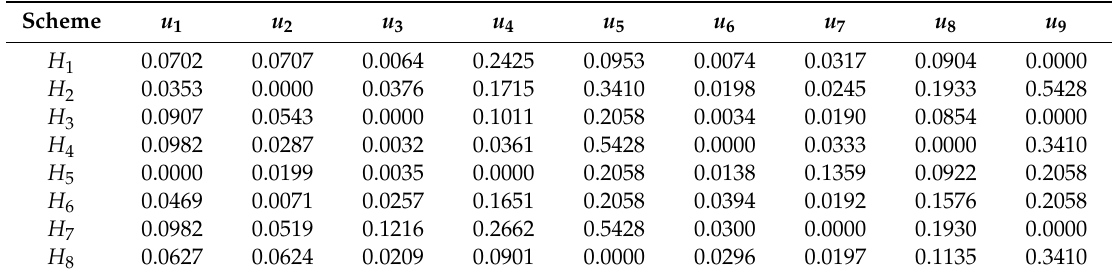
Table 5. Distance from attribute information of each scheme to H − .